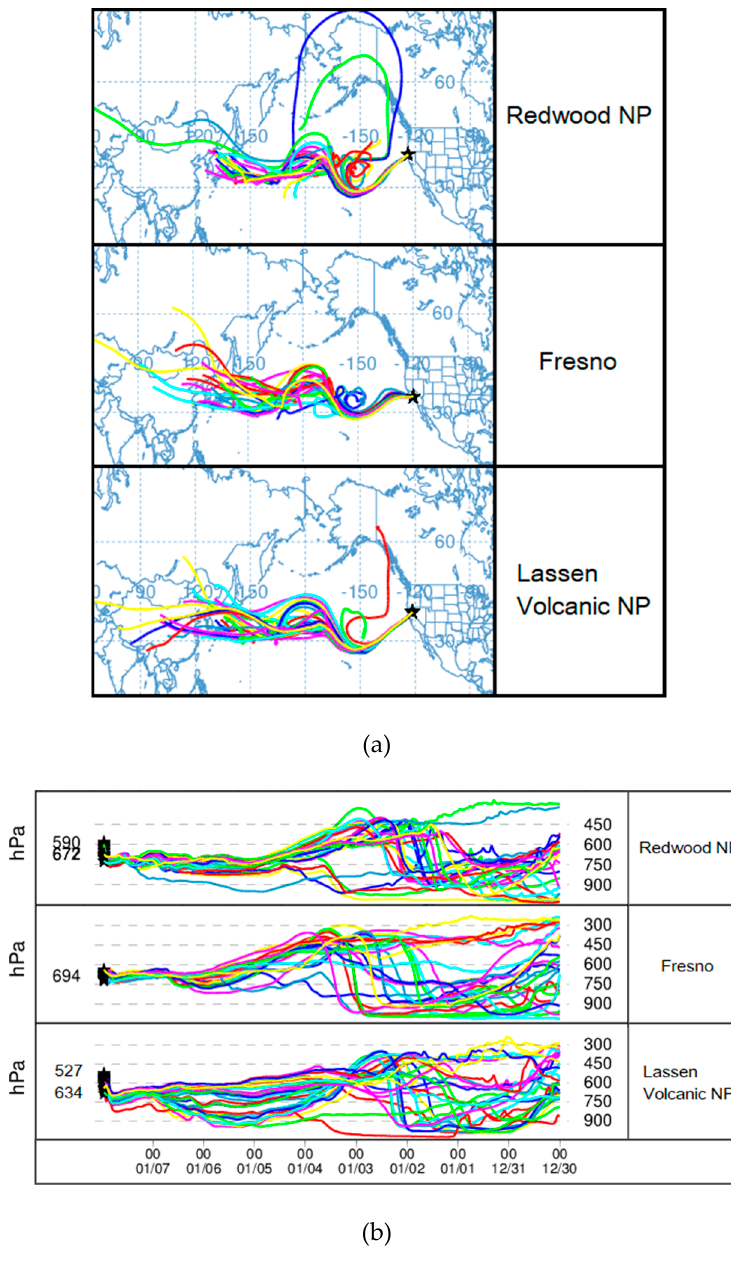
Figure 9. Hybrid Single-Particle Lagrangian Integrated Trajectory model (HYSPLIT) back trajectories from 01/07. ( a ) Redwood, Fresno, and Lassen Volcanic were shown to represent the coasts, inlands, and mountains, respectively. ( b ) air parcel height levels during the 10-day back trajectories.